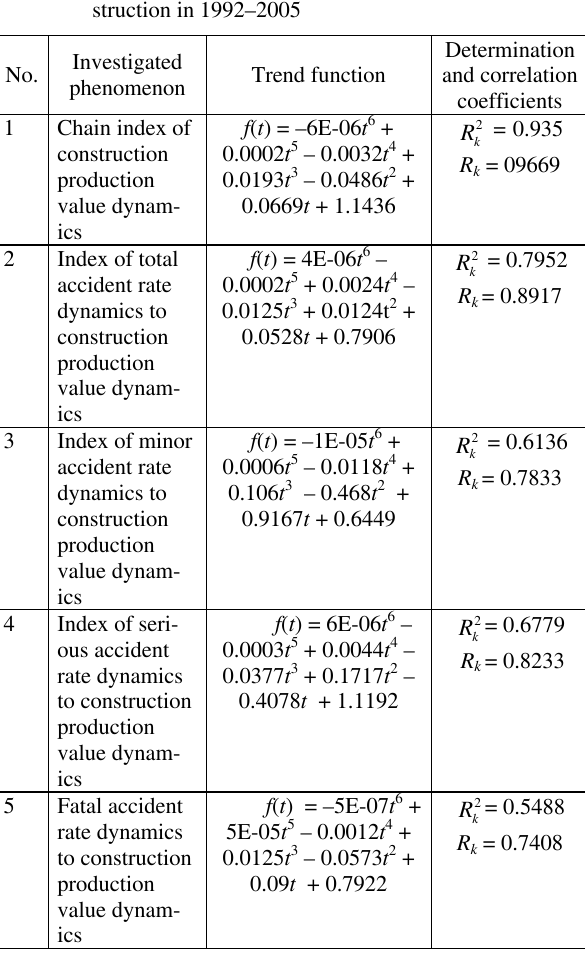
Table 5. Trend functions and determination and correlation coefficients for construction production dynamics in-